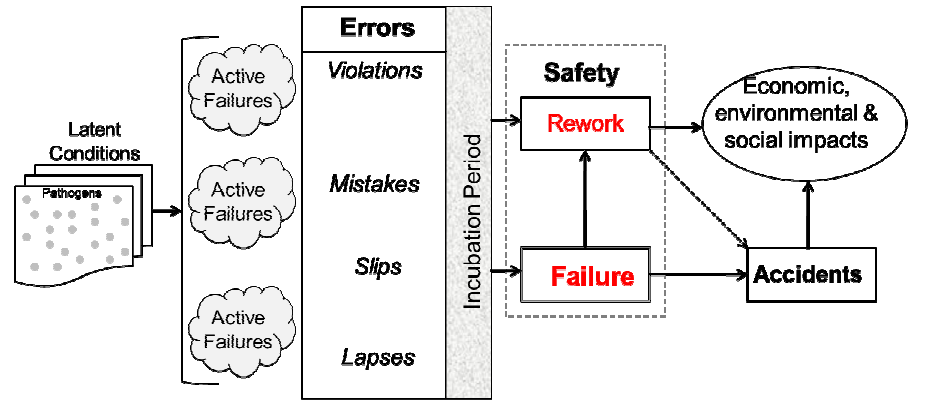
Fig. 3. Latent conditions, errors and rework (Love, Edwards